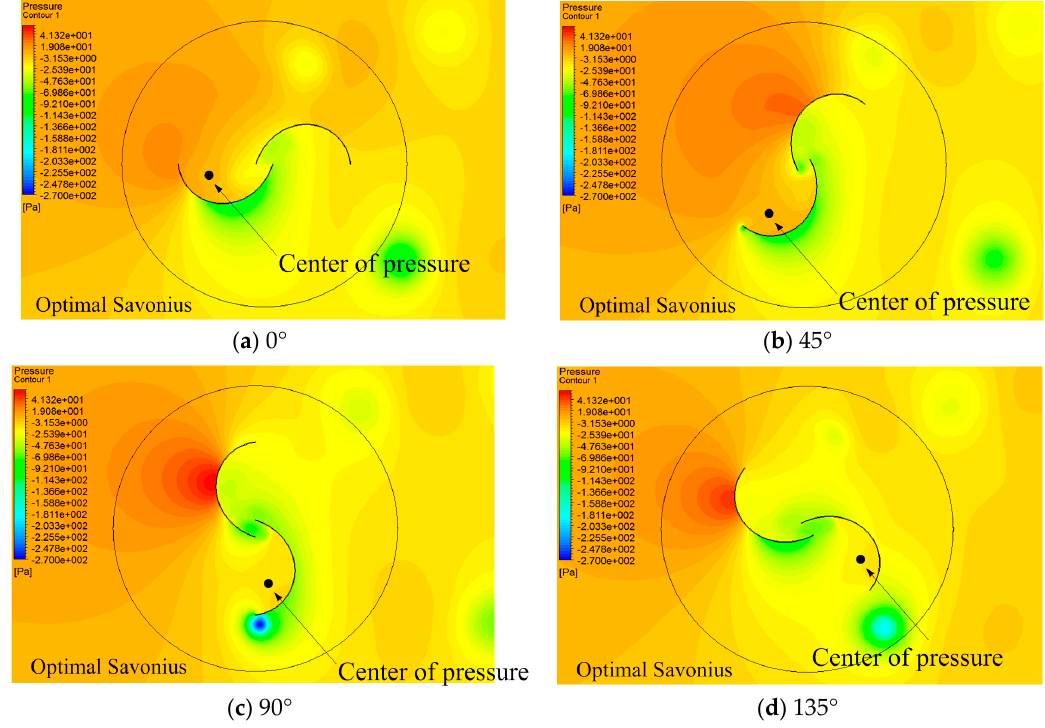
Figure 18. Pressure distributions of the local flow at different rotors angular positions.